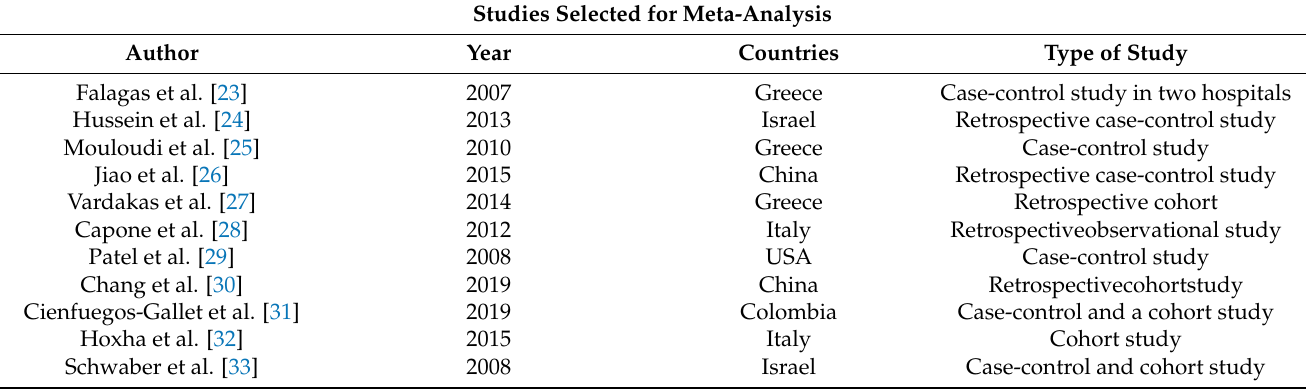
Figure 4. Flowchart for the selection process of articles used in the Meta-analysis. Table 1. Research selected for